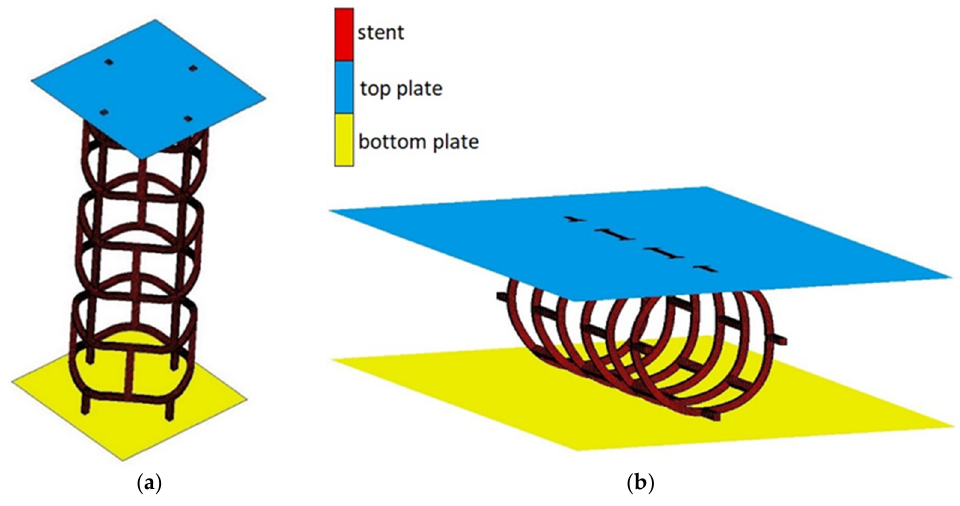
Figure 13. Stent compression: ( a ) longitudinal, ( b ) transverse. The same CAD-designed geometry, on which the numerical simulations were per- formed, was produced by microinjection moulding (Figure 14).